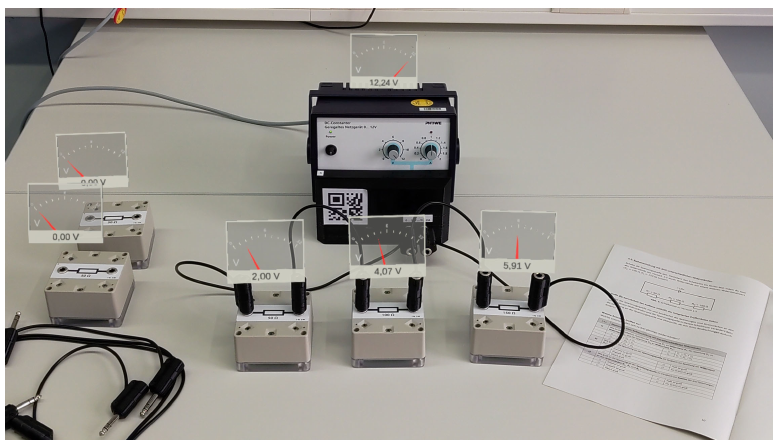
Figure 8. Screenshot of the custom Microsoft HoloLens 2 application captured by the